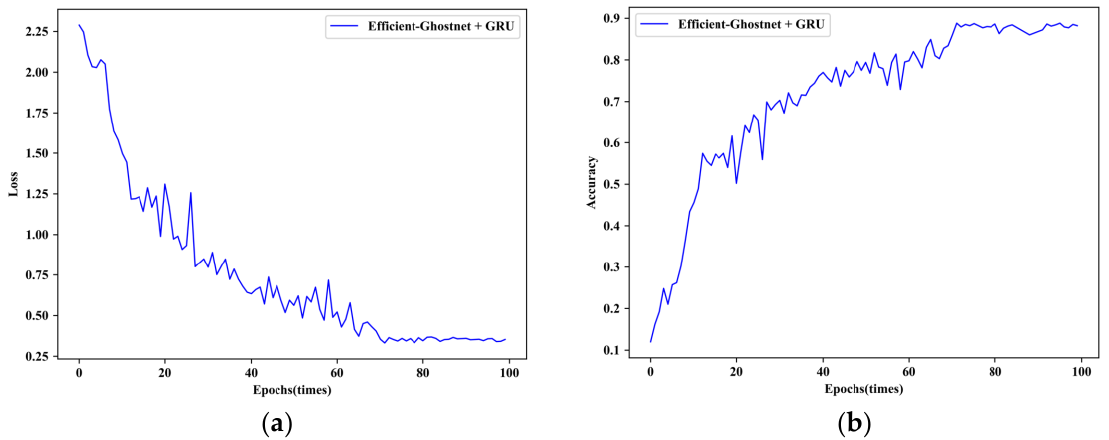
Figure 9. ( a ) Loss of each period in our network; ( b ) accuracy of each period in our network.